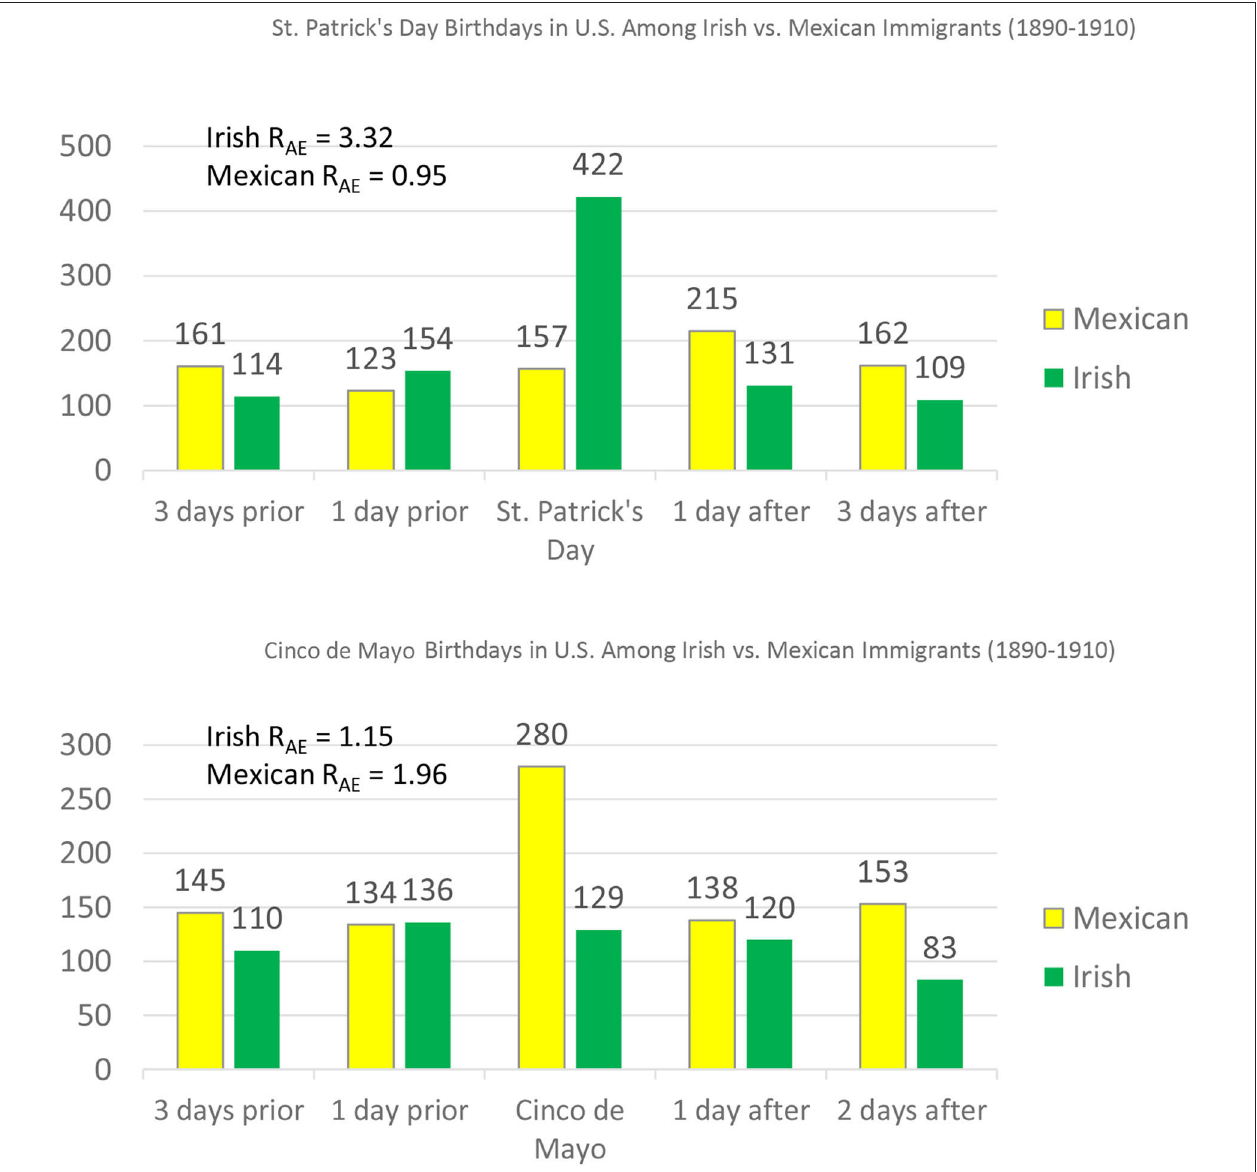
FIGURE 5 | Specificity of birthday selection by ethnicity among U.S. immigrants. We focused on three rather than two days after St. Patrick’s Day because March 19th is St. Joseph’s Day in Mexico. Further, we focused on three days prior to rather than two days prior to Cinco de Mayo because May 3 is Holy Cross Day in Mexico. Both holidays were overclaimed among Mexican